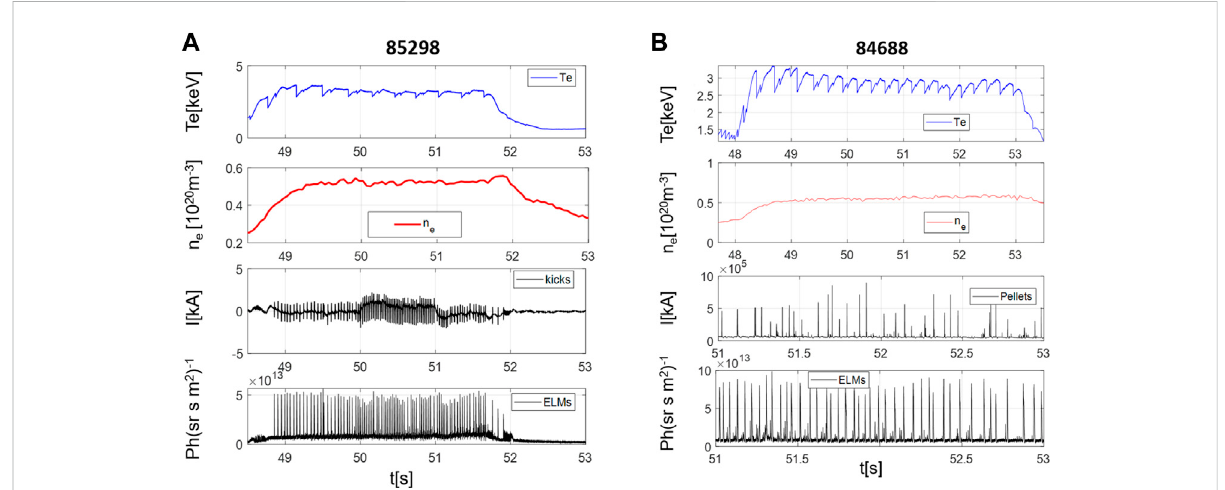
FIGURE 1 (A) example of ELM pacing via vertical kicks on JET. From top to bottom: central electron temperature, central electron density, currents in the ERFA ampli fi ers, D α to detect the ELMs (see Section 4.2). (B) example of ELM pacing with pellets in JET. From top to bottom: central electron temperature, central electron density, microwave cavity signal to detect the arrival times of the pellets in the plasma, D α to detect the ELMs (see Section